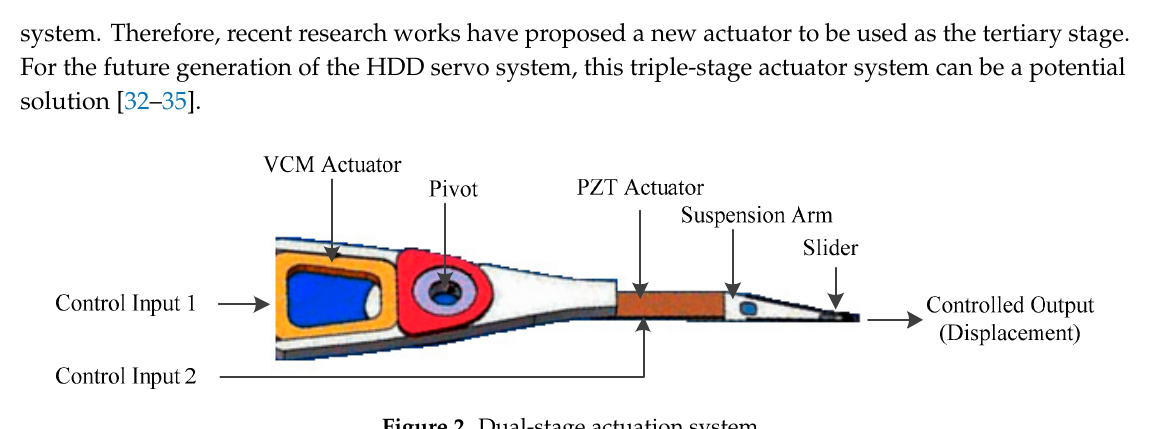
Figure 2. Dual-stage actuation system.